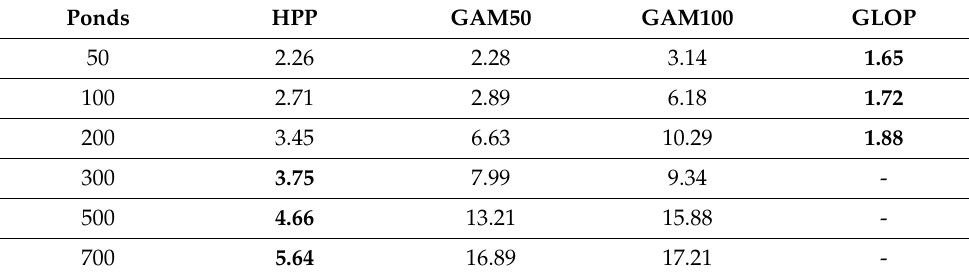
Table 5. Average Maximum Route Cost in Wind.